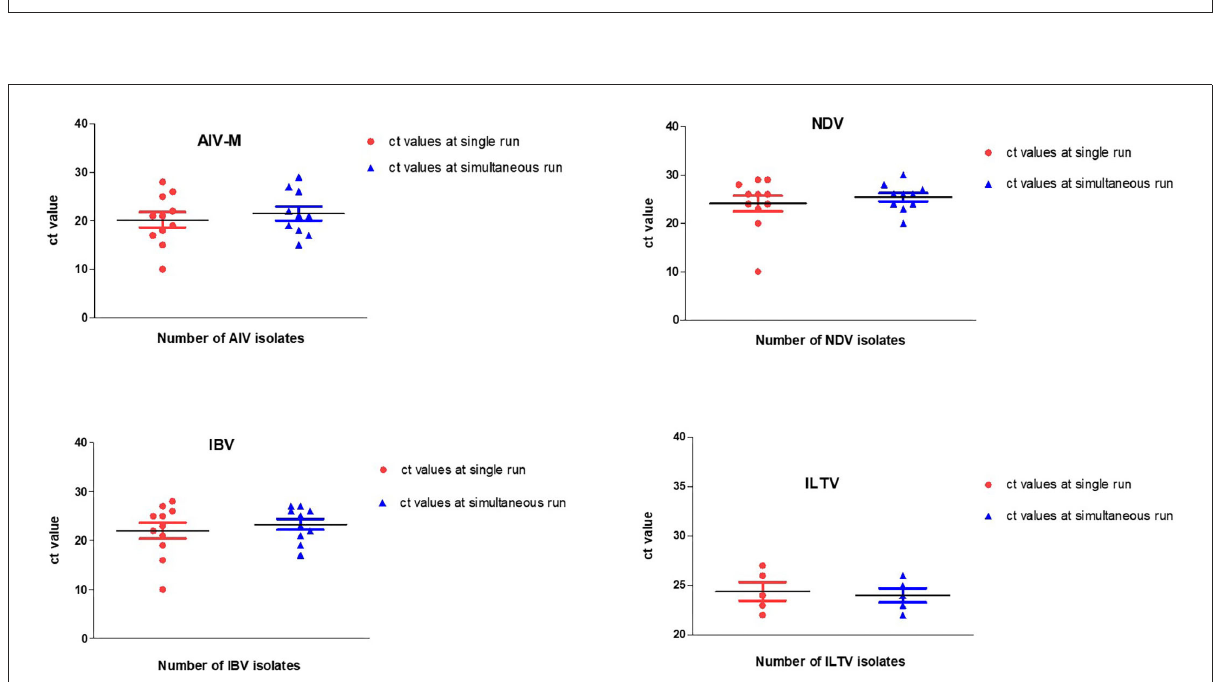
FIGURE2 Scatter plots representing Ct values at two independent RT-qPCR runs. There were no significant variations in Ct values generated using single-target single run and multitarget parallel RT-qPCR simultaneous